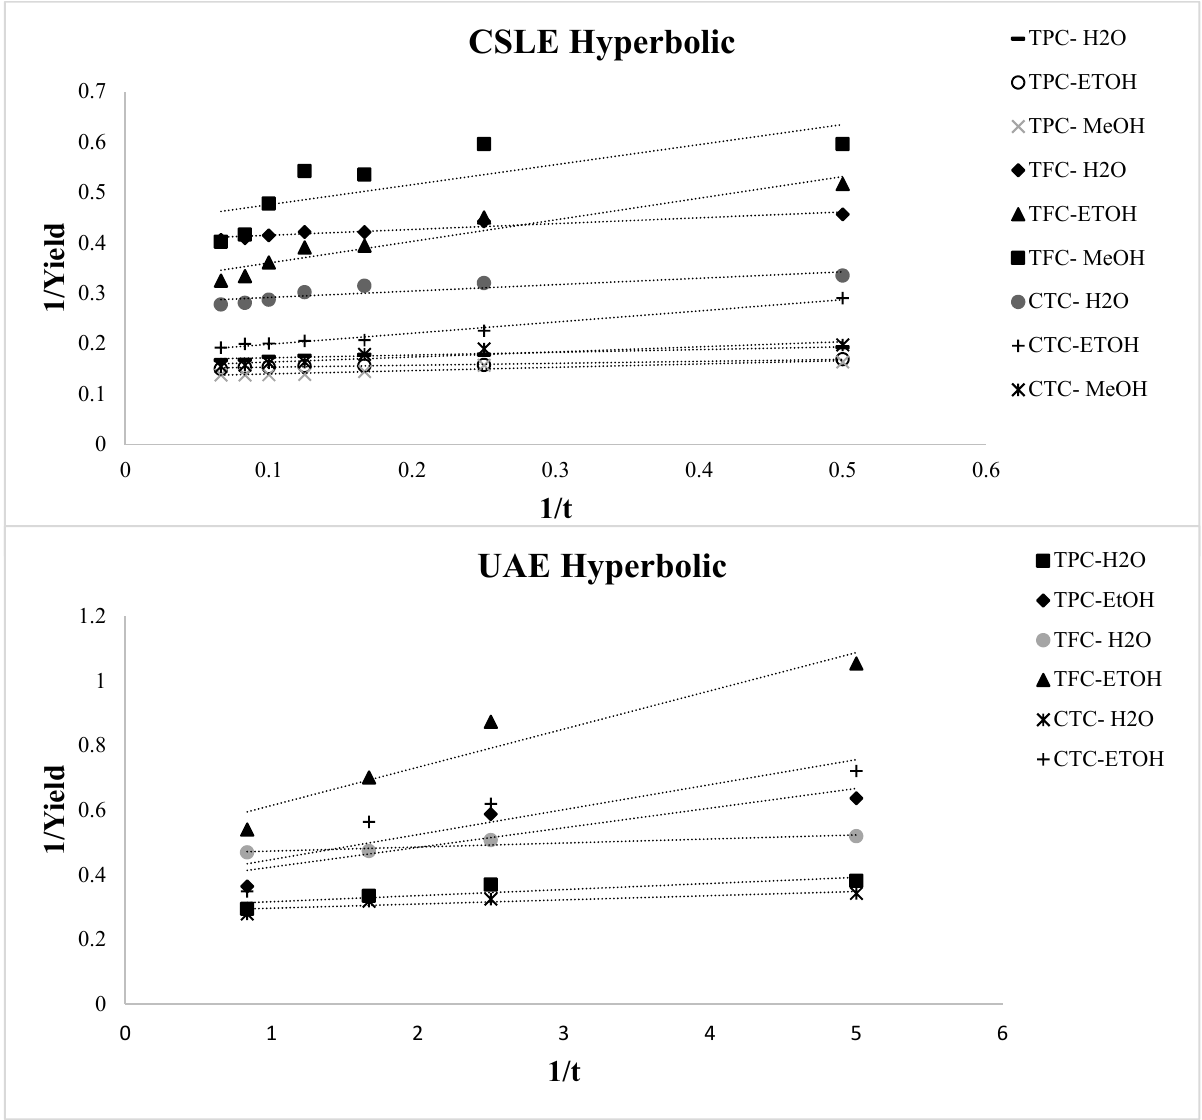
Figure 4. Plot of hyperbolic model for conventional solid-liquid extraction (CSLE) and ultrasound-assisted extraction (UAE) for the total phenolic compound (TPC), total flavonoid compound (TFC), and total condensed tannin compound (CTC) using the different selected solvents.